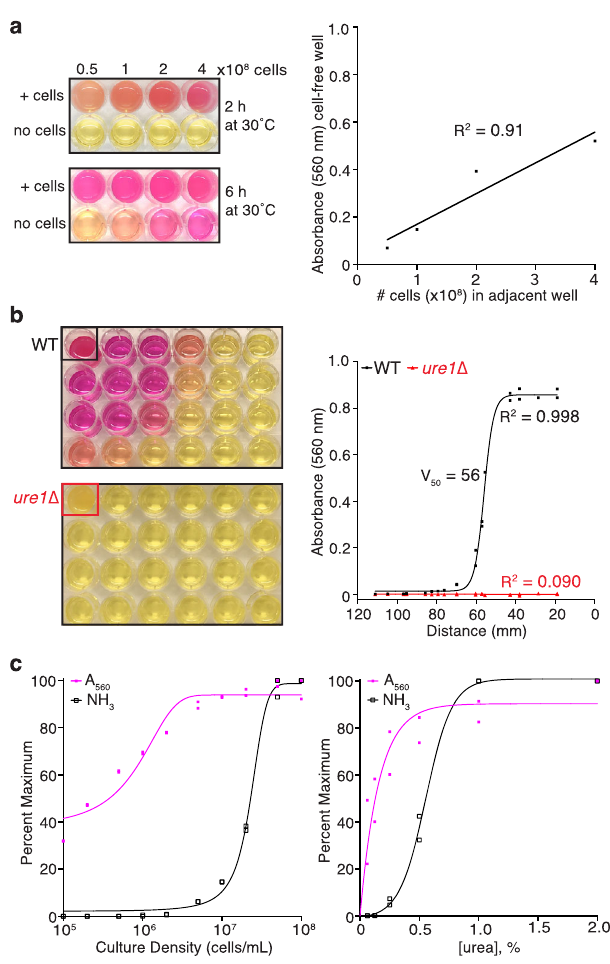
Fig. 1| C.neoformans ureaseproducesammoniathatactsatadistance.a Color photographs (left panel) of wells containing urea broth with the indicated number of C. neoformans cells or no cells following incubation at 30°C for 2 or 6h. Absorbanceat560nm(A 560 )ofcell-freemediaafter6hshowsalinearincreasewith increasing numbersof cellsinadjacent wells(right panel). b Platescontaining urea broth in all wells and 1×10 8 wild-type (WT) or ure1 Δ cells in the top left well (A1) photographedafter24hat30°C(leftpanel).AsigmoidalrelationshipbetweenA 560 and proximity to well A1 (right panel) is observed for WT but not urease-de fi cient cells. c Percent maximum A 560 of culture supernatant (pink) and ammonia gas (NH 3 , black) measured for WT cultures grown in urea broth at 30°C for 24h with increasing starting cell density (left panel) or increasing urea concentration (right panel). Source data are provided as a Source Data fi